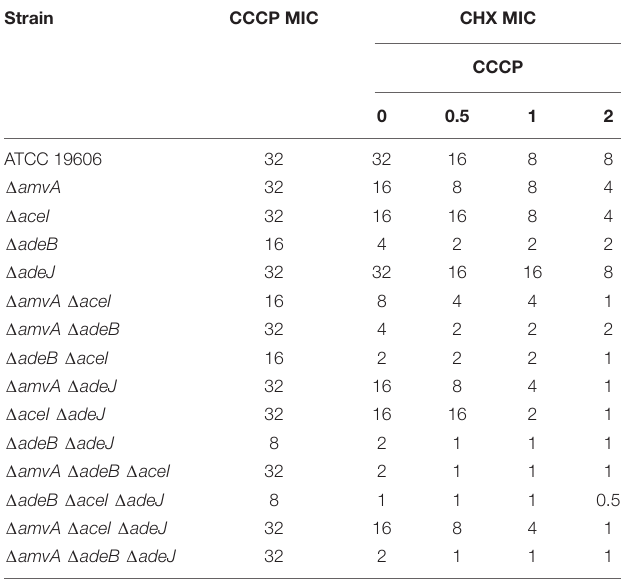
TABLE 3 | MIC of CHX (mg/L) in combination with CCCP of A. baumannii ATCC 19606 parental strain and EP deletion mutants. Strain